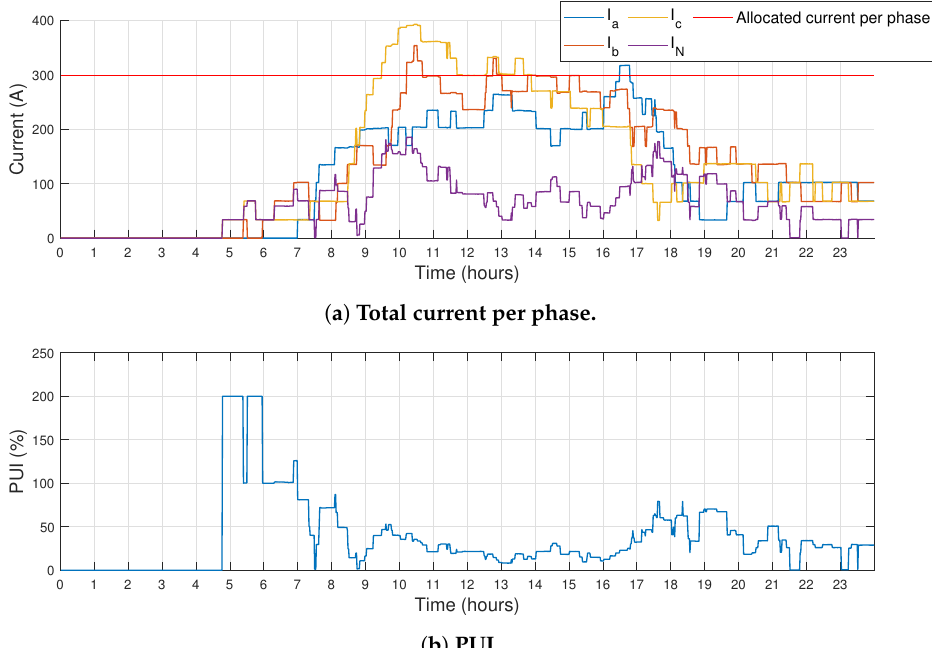
Figure 9. Total current per phase consumed by the charging infrastructure during the simulated day and the PUI. ( a ) Total current per phase and ( b )